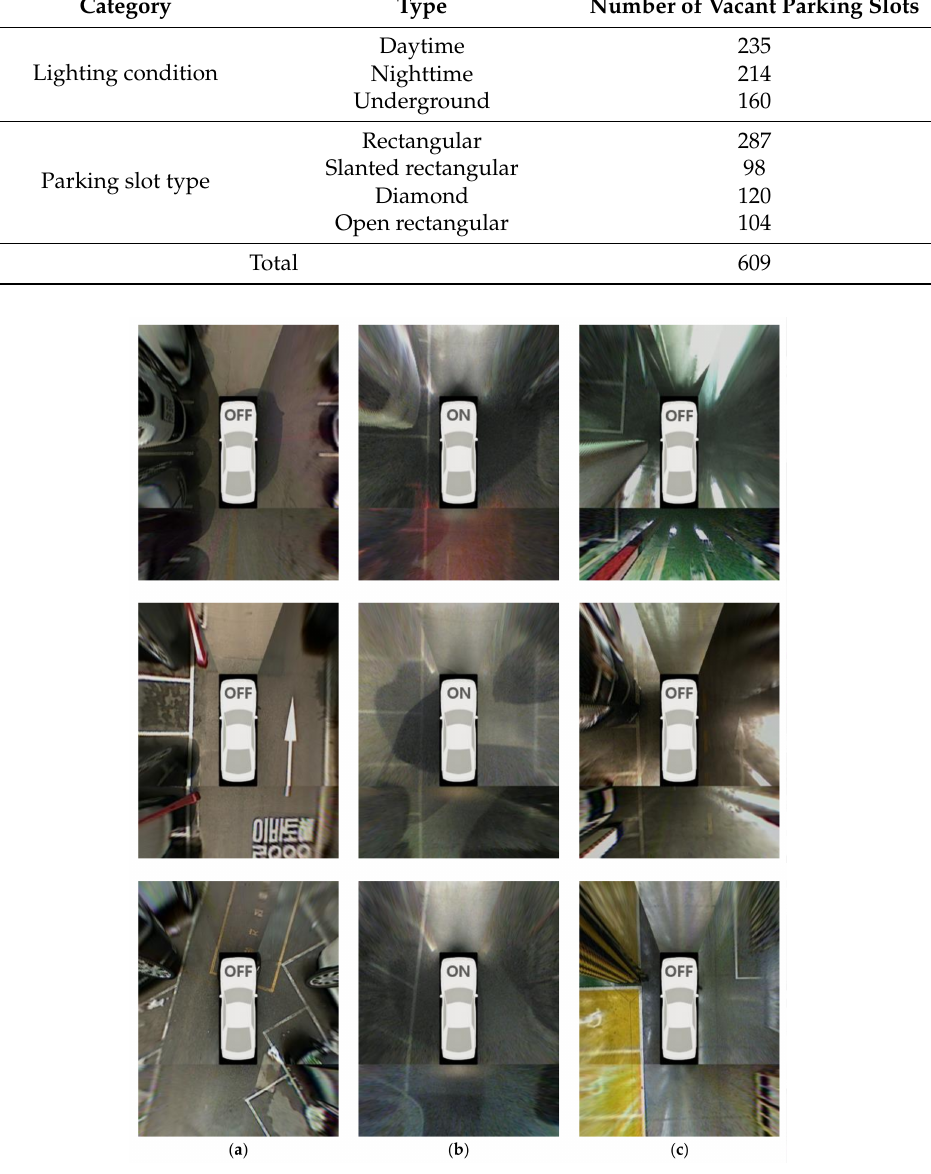
Figure 12. AVM images included in the test dataset. ( a ) Daytime; ( b ) Nighttime; ( c )